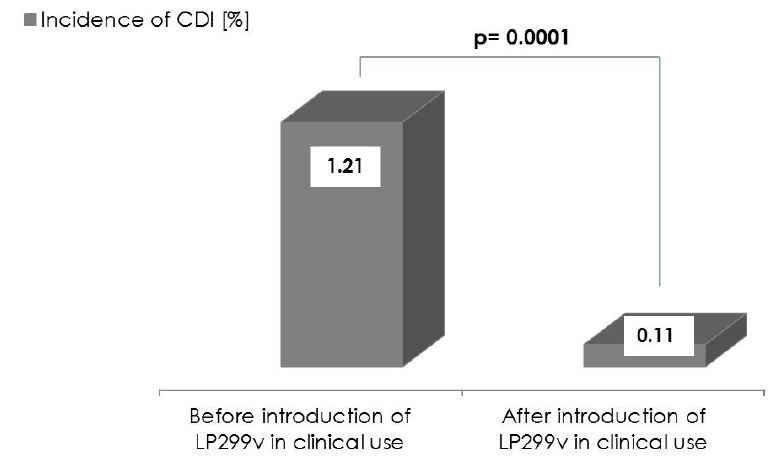
Figure 1. The incidence of CDI before and after administration of Lactobacillus plantarum 299v (LP299v). Nosocomial infection was identified in 14 patients (61% of total CDI cases) and community-acquired CDI was recognized in 3 (13%) patients. In six cases (26%), the infection was associated with the other health care facility and the onset of symptoms was suspected before the admission to our hospital. The average time between the onset of symptoms and the diagnosis of CDI was 7.3 ± 7.0 days. The main clinical symptom of CDI observed in 23 (100%) patients was diarrhea with different intensity, sustained for 14.0 ± 10.5 days. The average number of stools per day was 6.2 ± 2.9. During the infection there was a reduction in the body weight in 12 patients. In these patients, the mean reduction of body weight was 5.9 ± 4.6 kg.